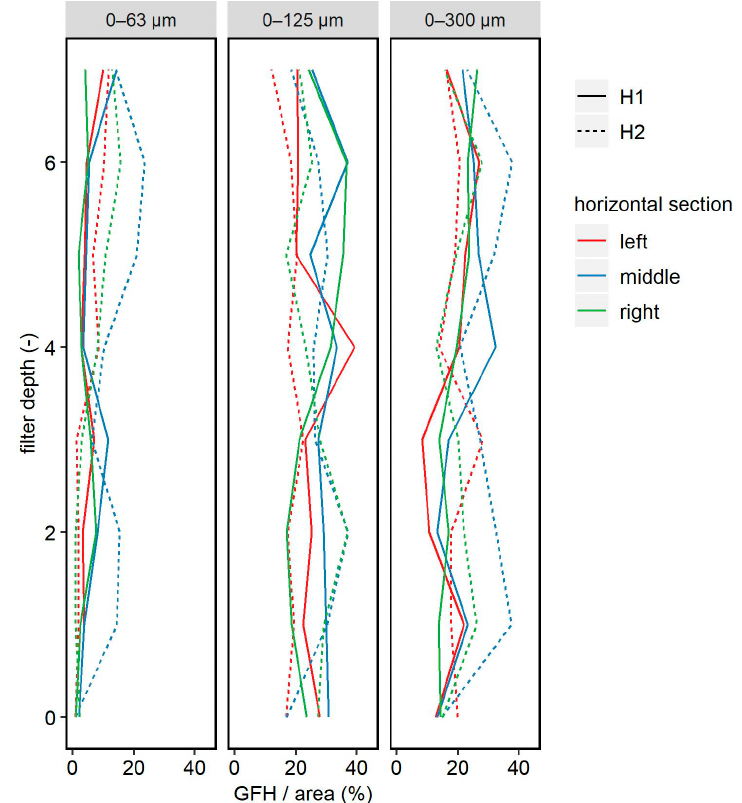
Figure 6. Vertical and horizontal distributions of μ GFH in cross sections depending on particle size.